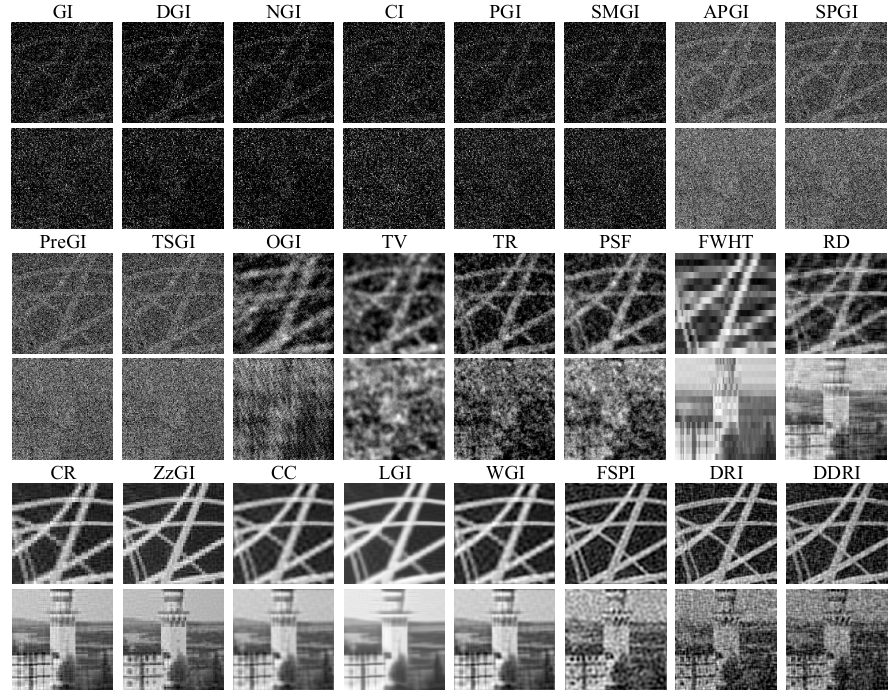
Figure 4. Simulation results of twenty-four methods with WGN. The noise level is 50.